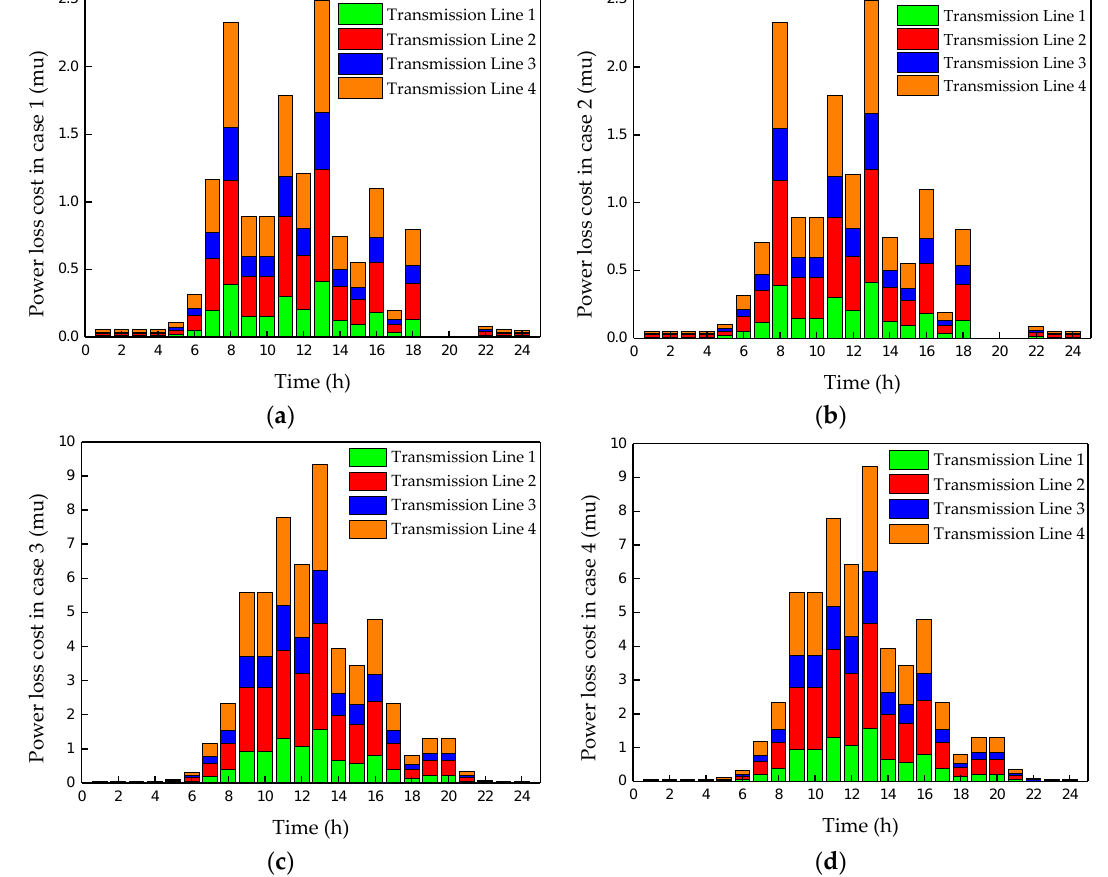
Figure 12. Power loss cost on the transmission network for different cases: ( a ) Case 1; ( b ) Case 2; ( c ) Case 3; ( d ) Case 4.